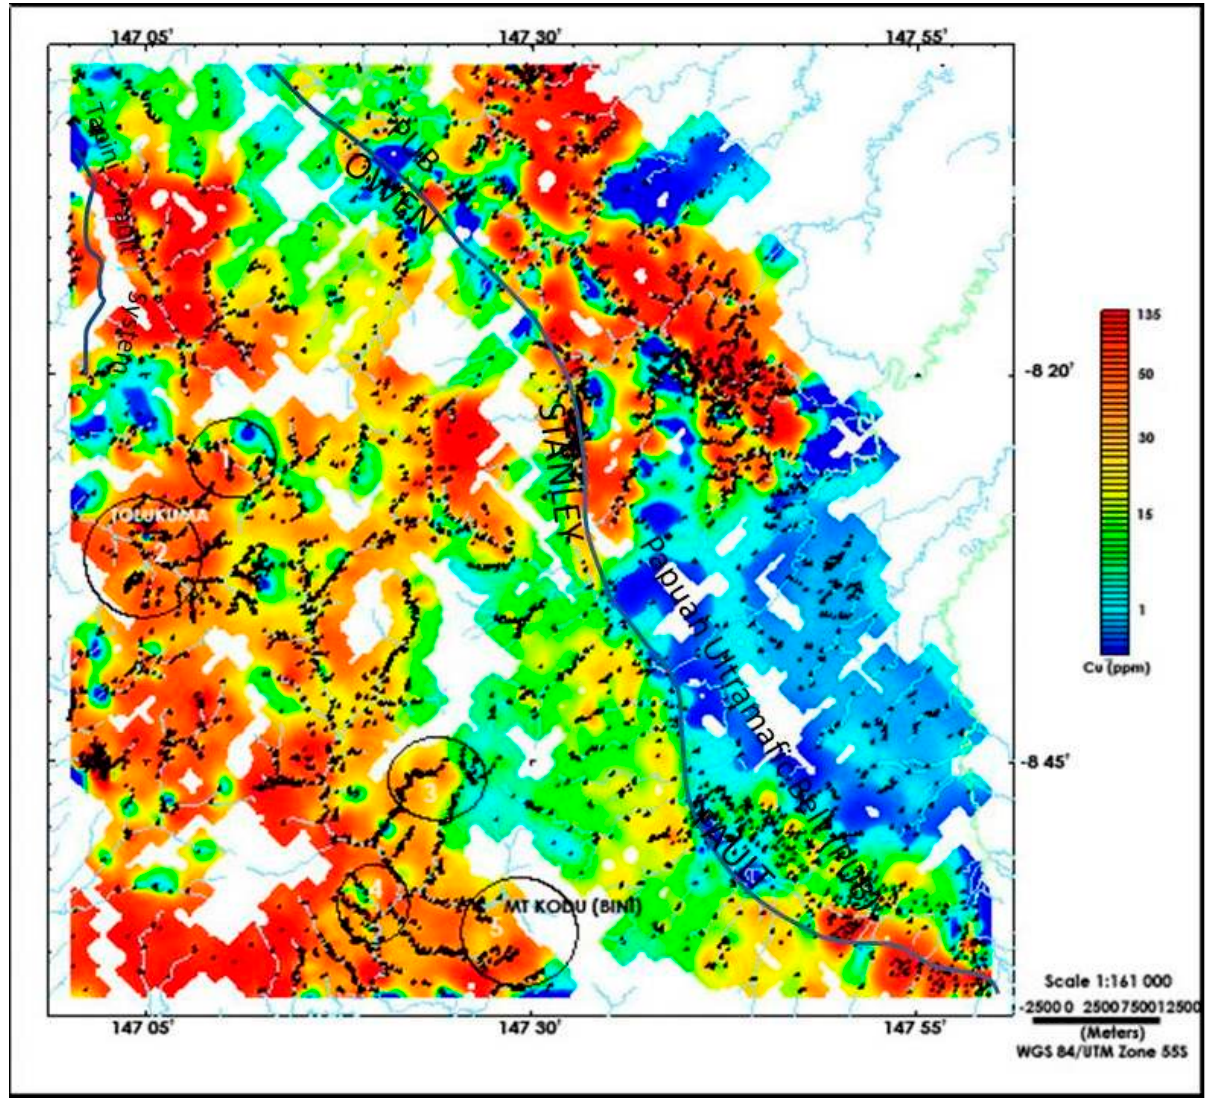
Figure 5. Distribution of copper in stream sediment data from the study area. The locations of sampling points are shown on the map as black dots. Numbers 1 − 5 in the figure indicate magnetic anomalies shown in Figure 3.